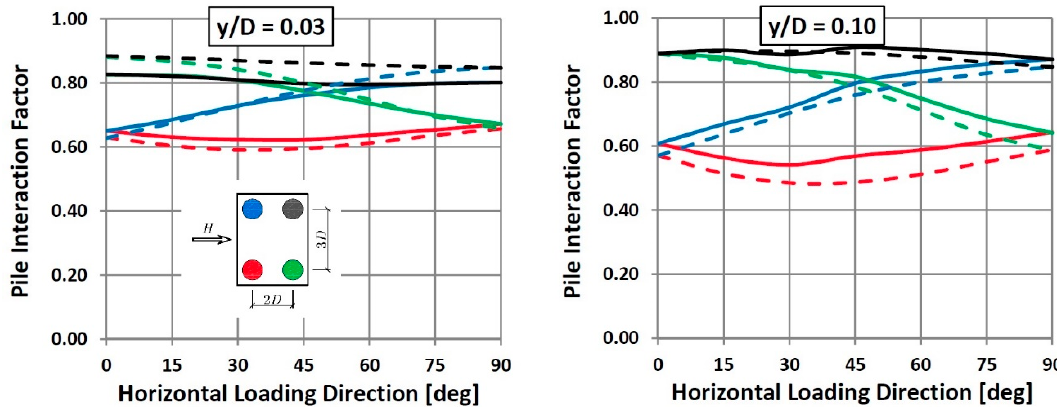
Figure 11. Pile interaction factors for rectangular 2 × 2 pile group ( s x = 2 D , s y = 3 D ). Different colors denote piles inside the pile group. Full lines—loose sand; dashed lines—dense sand.